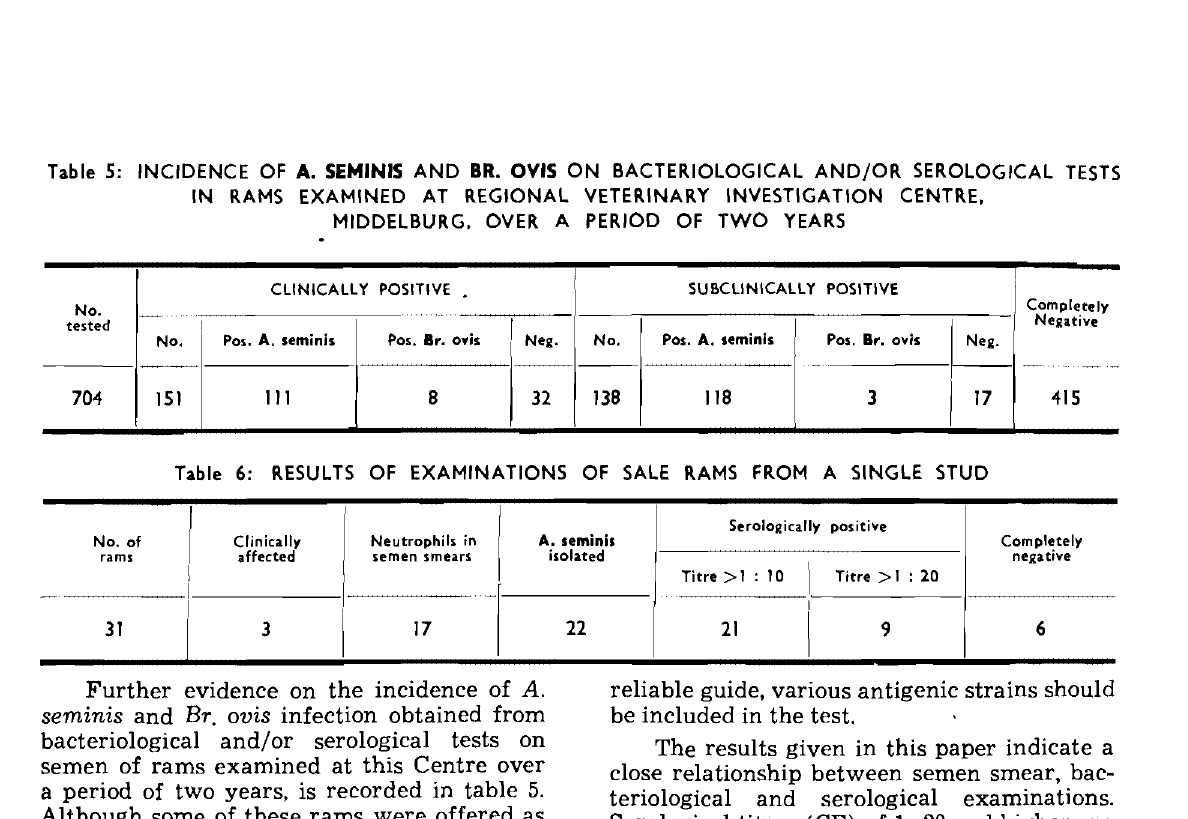
Serologically positive